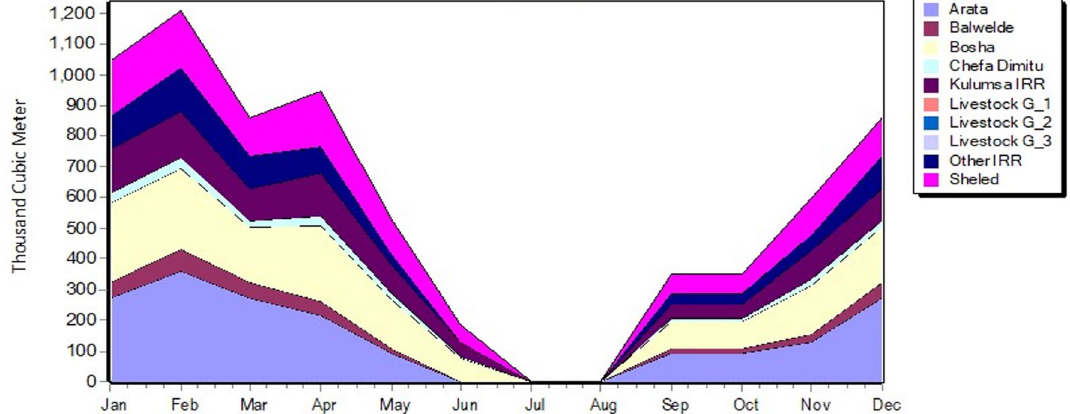
Fig. 9 Total demand for Arata catchment (WEAP Result)